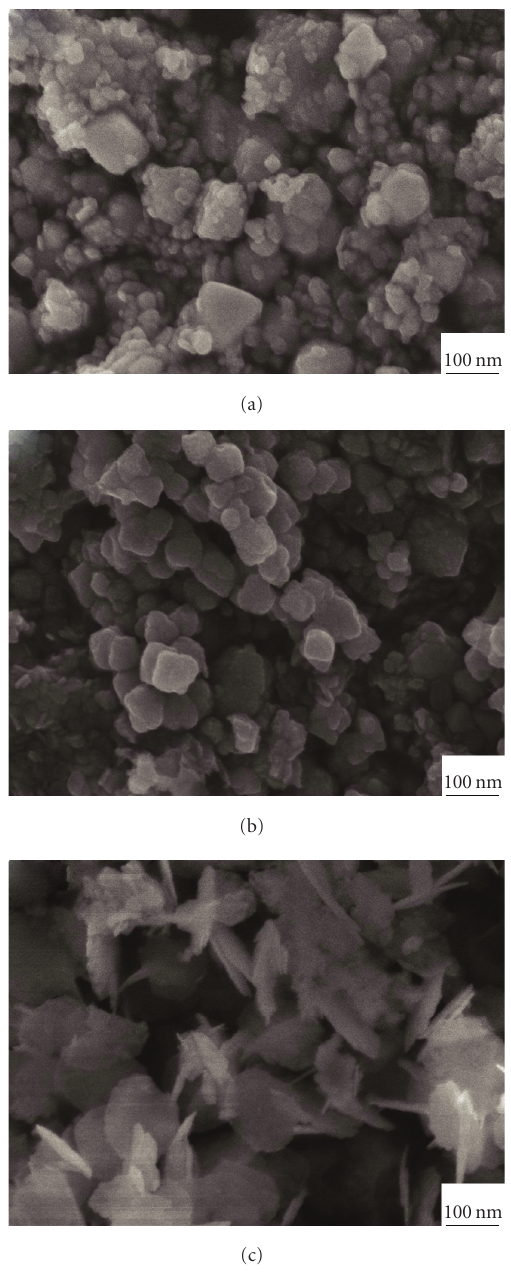
Table 1: Lattice parameters, density, and orientation degree ( O hk